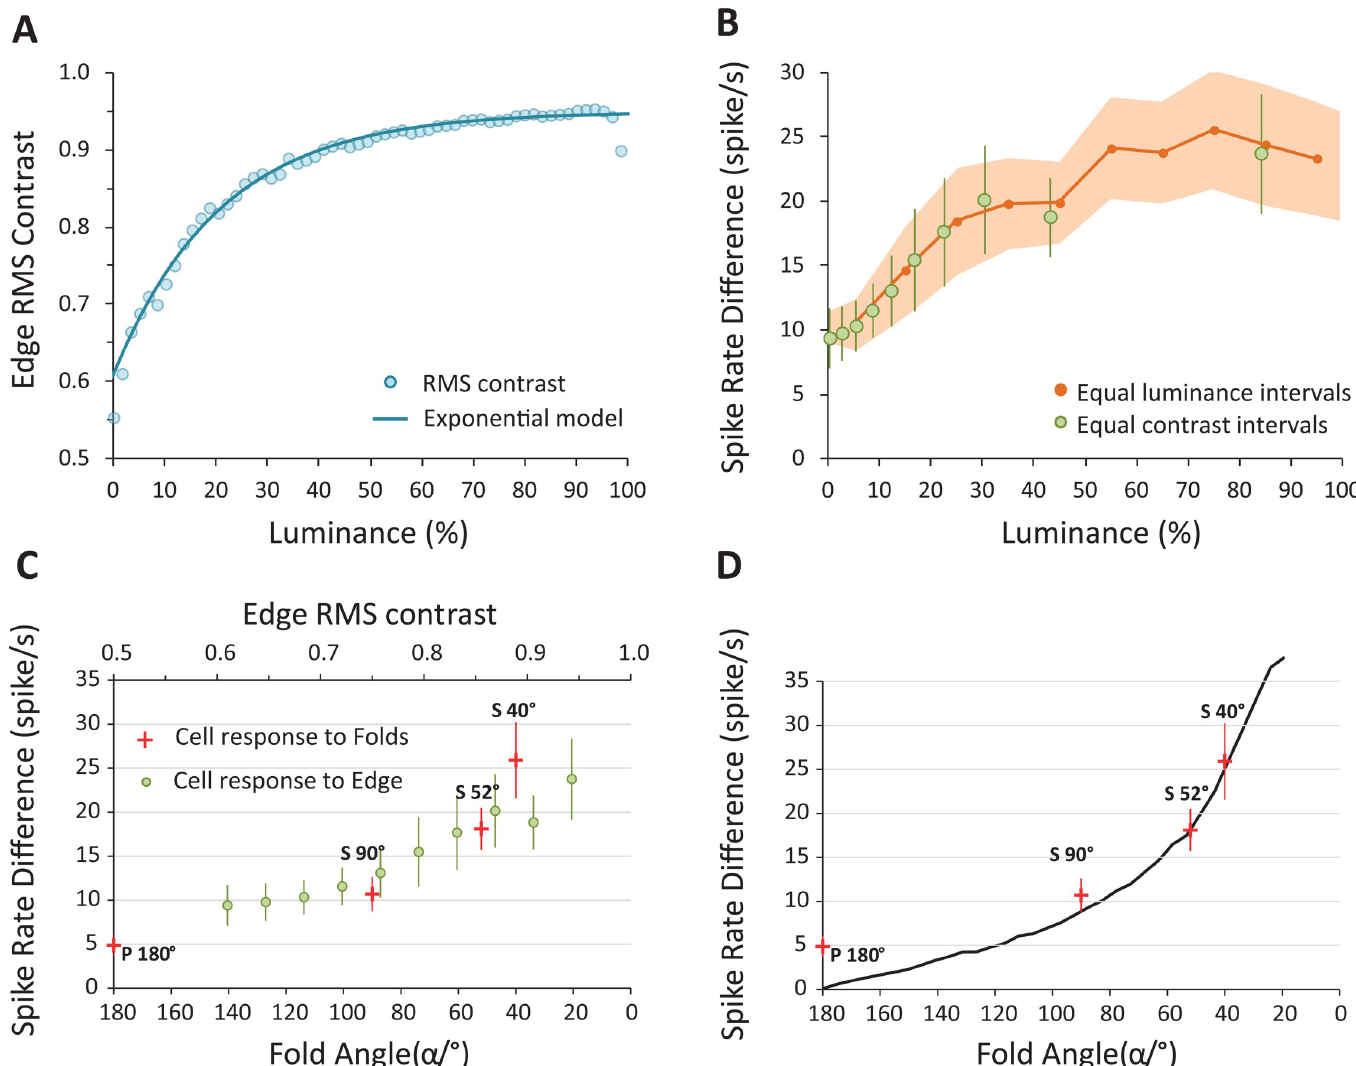
Fig 7. Neural responses to corner-folds vs. those to edge. ( A) Root-Mean-Square (RMS) contrast along Edge. The light cyan dots show the numerically computed values of RMS contrast at various luminance levels along Edge. The dark cyan line is the exponential fit for Edge RMS contrast: f l ð Þ ¼ (cid:0) 0 : 34 � exp (cid:0) 0 : 05 � l ð Þ þ 0 : 95 , where l is the luminance in percentage and f l ð Þ is the RMS contrast. This model was used to calculate neural responses along Edge at equal RMS contrast intervals. ( B ) Neural responses along Edge. The orange dots indicate the neural responses along the Edge at equal luminance intervals of 10% (red shadows indicate the SEM), while the green dots indicate the neural responses at equal RMS contrast intervals of 0.037. ( C ) Neural responses to corner-folds and Edge. The red crosses represent the average neural response (spike rate difference) to the four corner-fold angles (at fold midpoints). The green dots are the neural response to Edge at equal contrast intervals, as described in (B). ( D ) Neural responses as a function of fold angle (red crosses) compared to DOG output (black line) obtained with similar stimuli [3]. Error bars indicate the SEM (the N are as in Fig 5